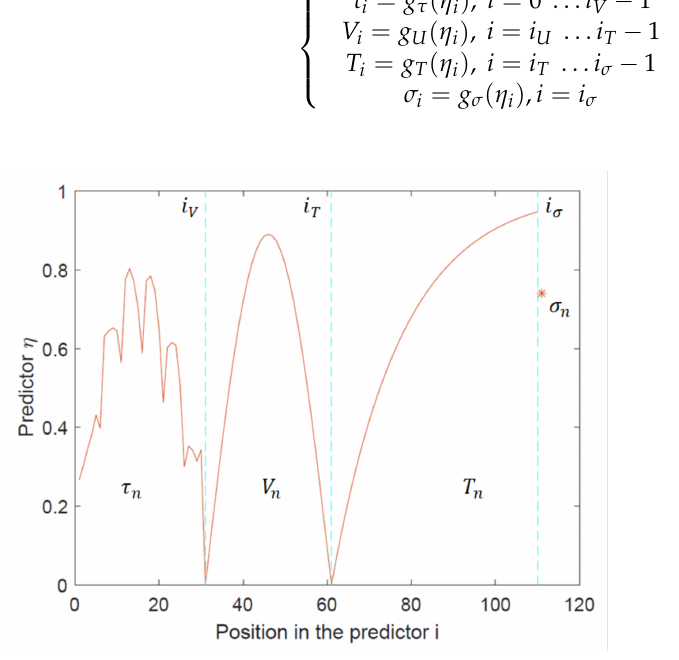
Figure 9. Forming a single predictor vector η using normalized data corresponding to torque, back emf, temperature, and mechanical